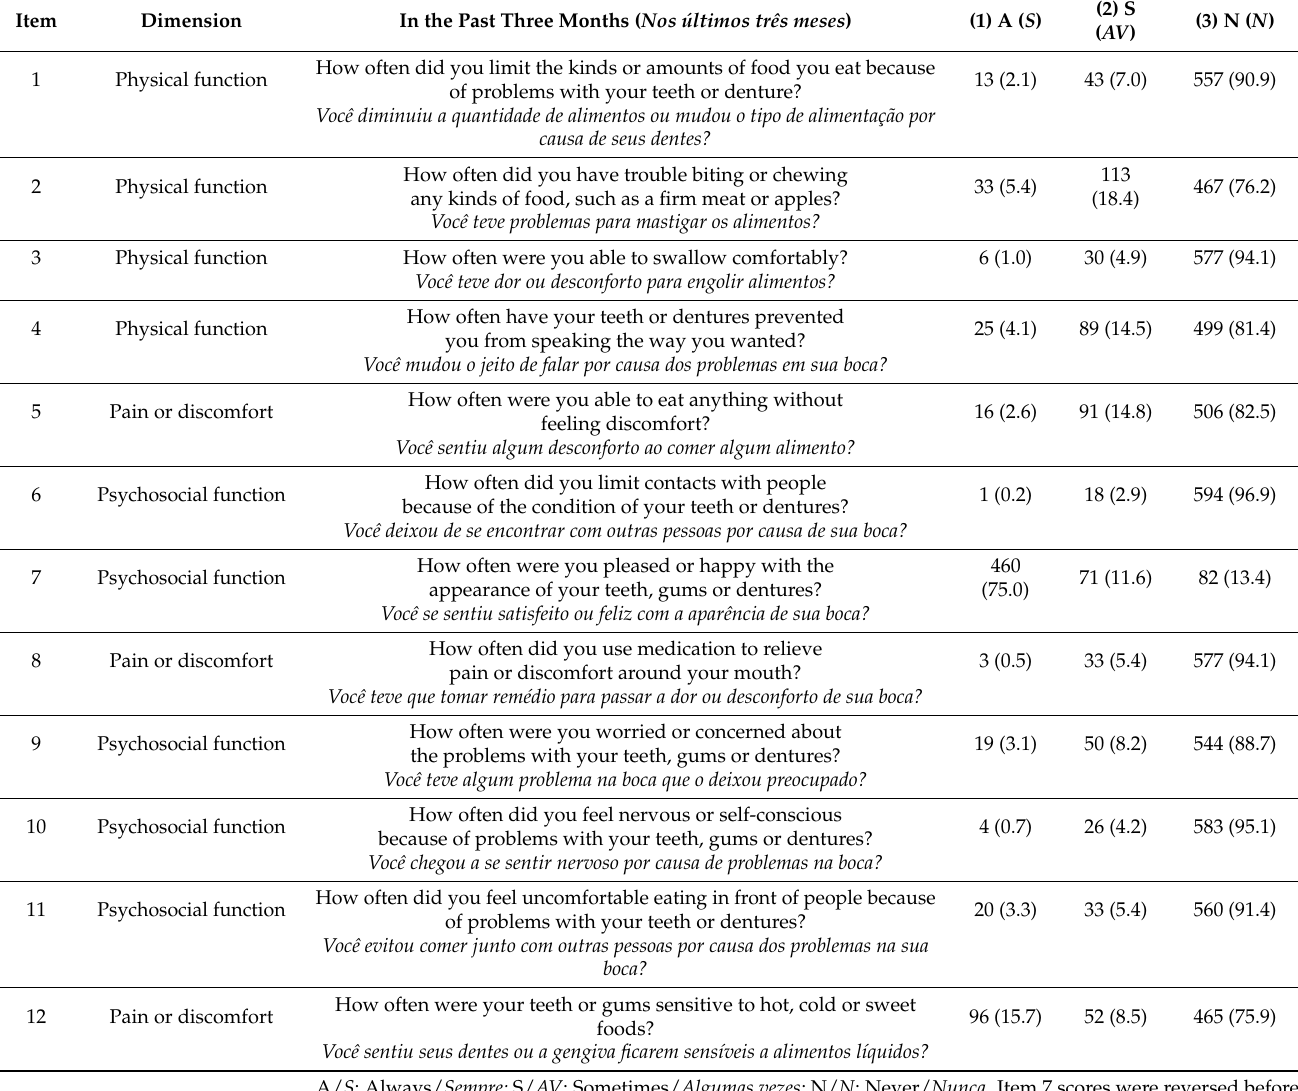
Table 1. GOHAI items and frequency distribution of the responses ( n =